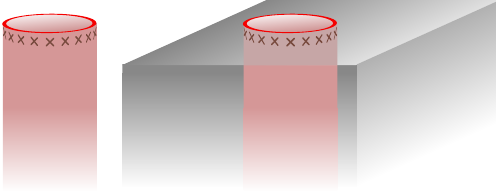
Figure 16 . Higher-dimensional construction based on CFT-Vaidya